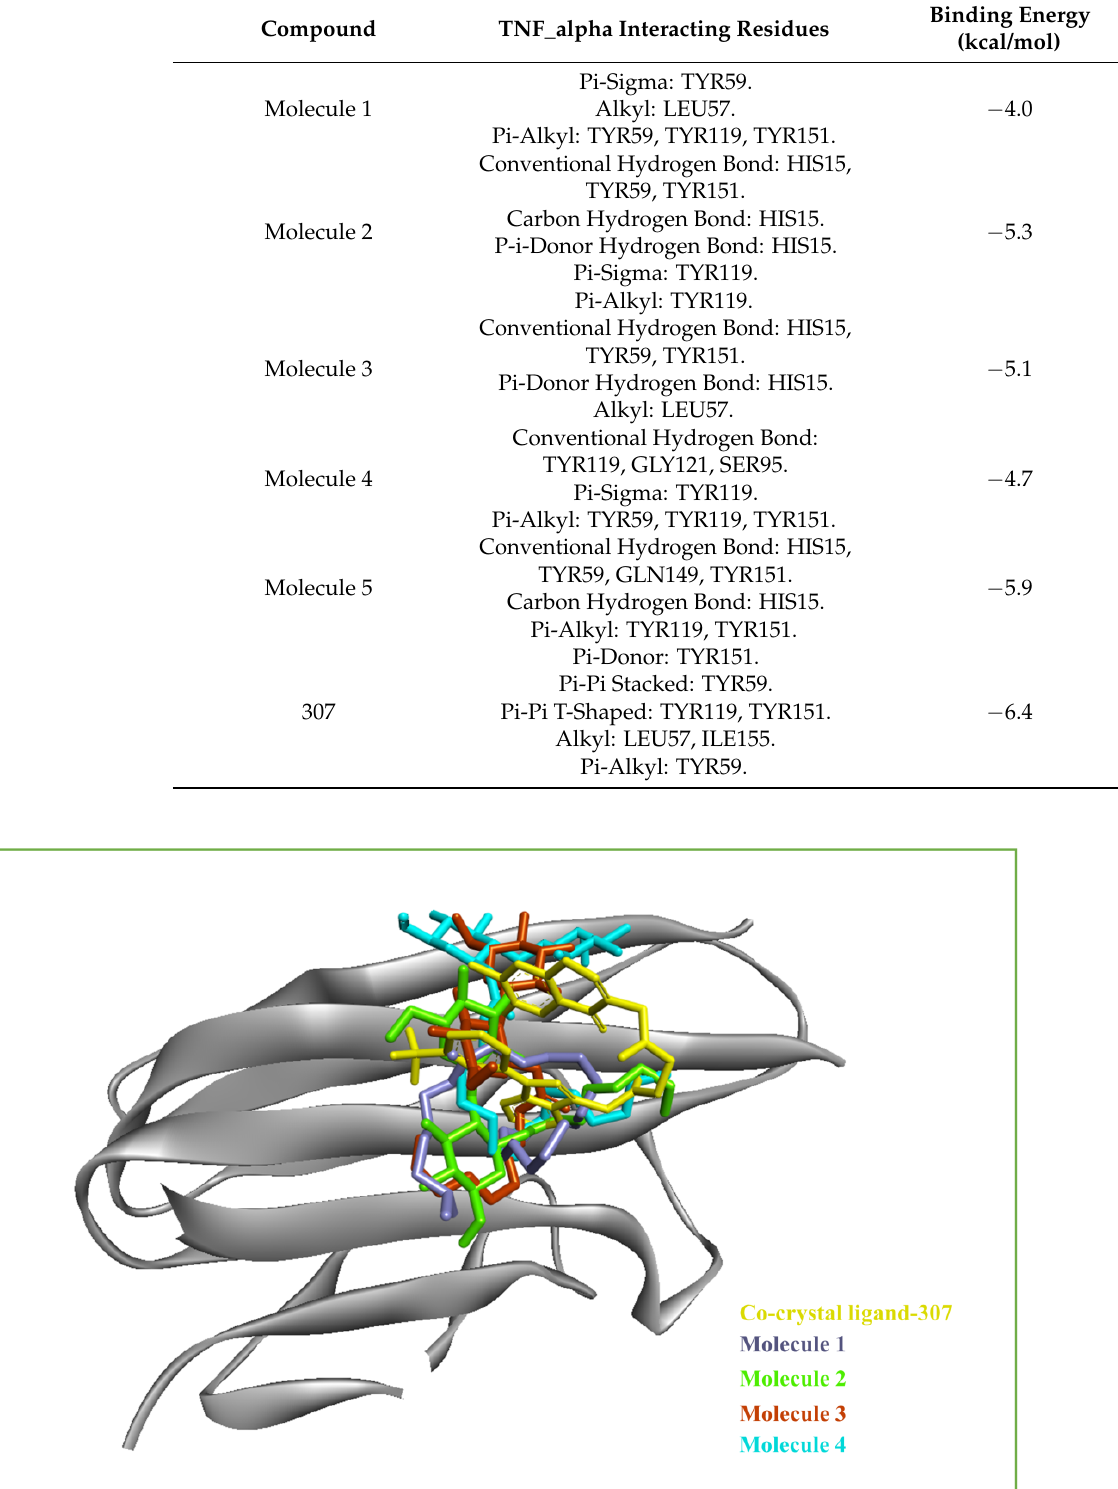
Table 3. Intramolecular interactions among the extracted molecules and the active site residues of